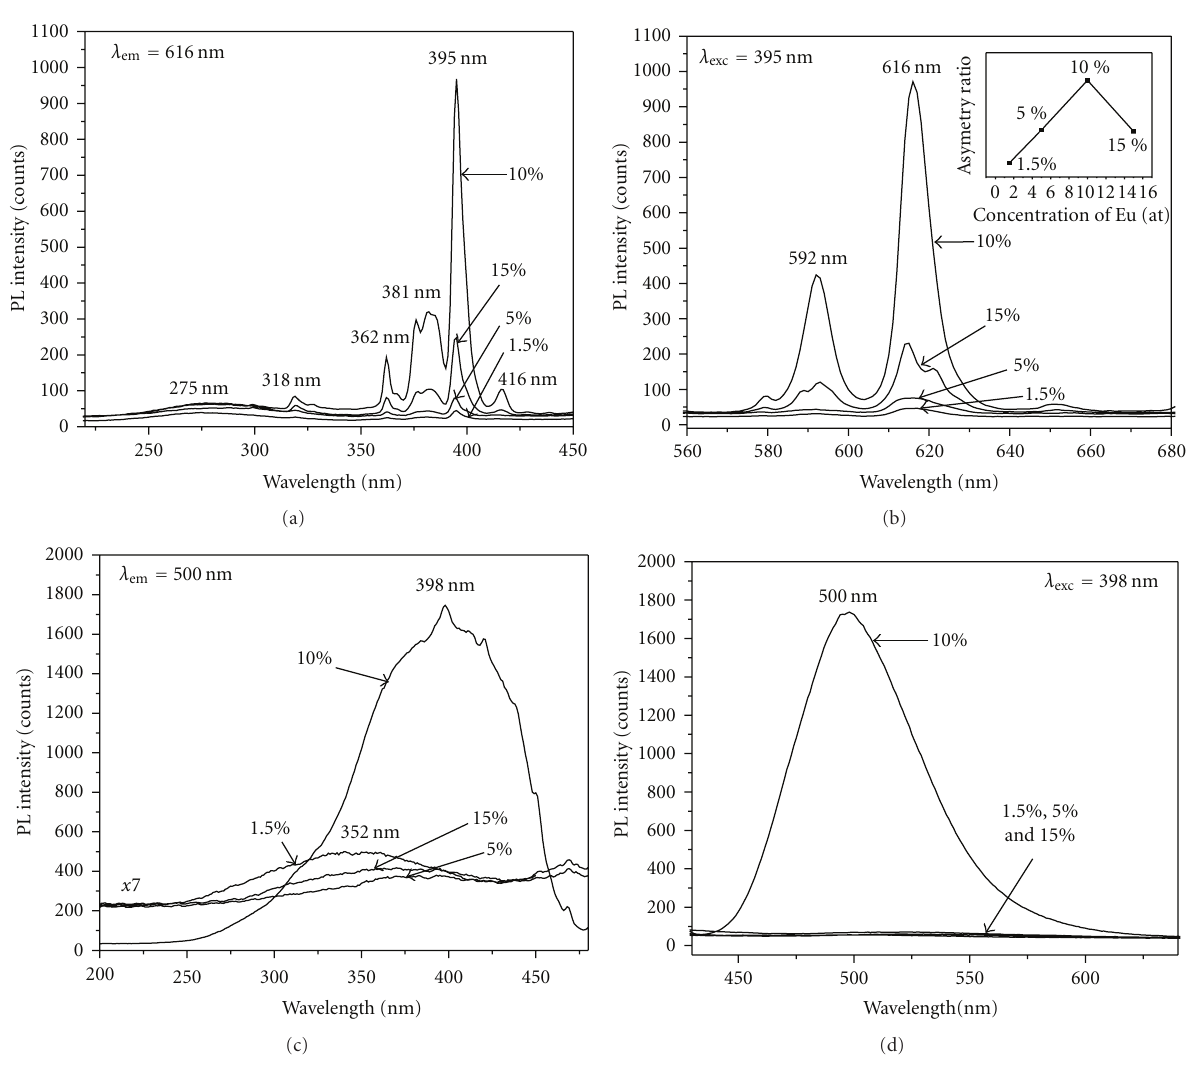
Figure 4: PL spectra of luminescent powders, x = 1 . 5–15.0 at % Eu, produced by PACS: (a) excitation spectra for all Eu-doping concentrations at fixed λ em = 616 nm (red) and (b) emission spectra for all powders excited with λ exc = 395 nm. The inset shows the highest asymmetry ratio value at 10.0 at % Eu-doping concentration. All measurements performed at room temperature. After RIRO: (c) excitation spectra for all Eu-doping concentrations at fixed λ em = 500 nm (green) and (d) emission spectra for all powders excited with λ = 398 exc